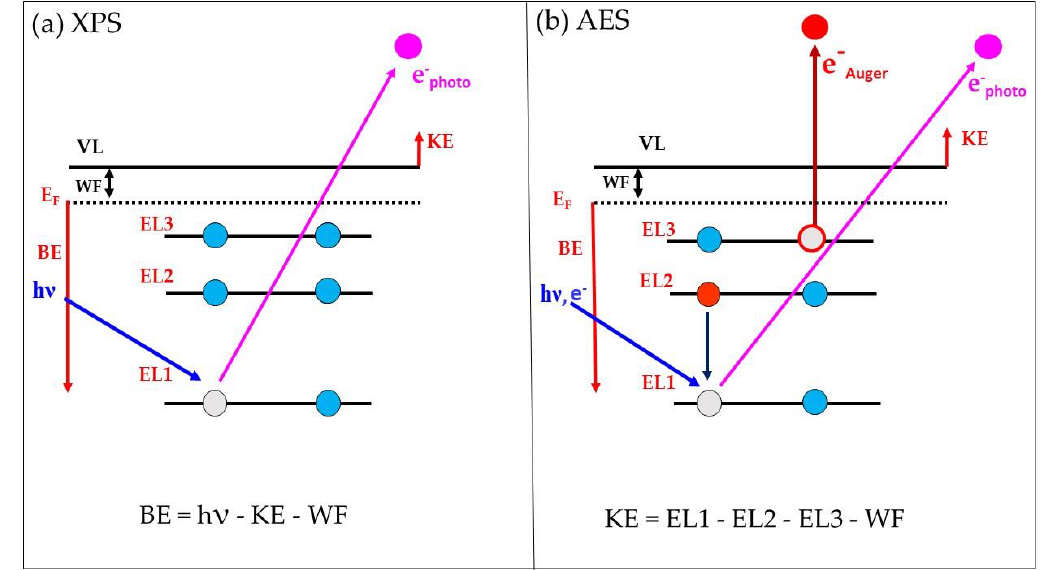
Figure 1. Schematic diagram of the final state in photoemission ( a ) and Auger ( b ) excitations.